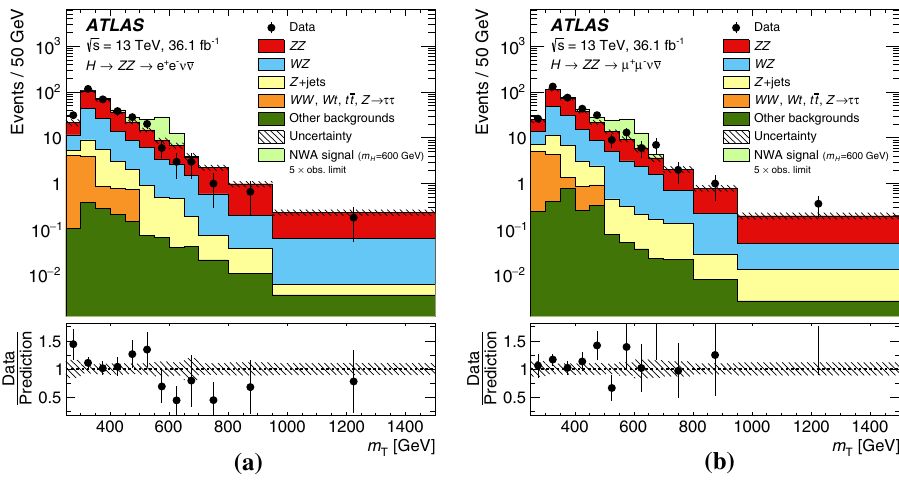
Fig. 5 Transverse mass m T distribution in the (cid:3) + (cid:3) − ν ¯ ν search for a the electron channel and b the muon channel, including events from both the ggF-enriched and the VBF-enriched categories. The backgrounds are determined following the description in Sect. 6.2 and the last bin includes the overflow. The simulated m H = 600 GeV signal is normal-